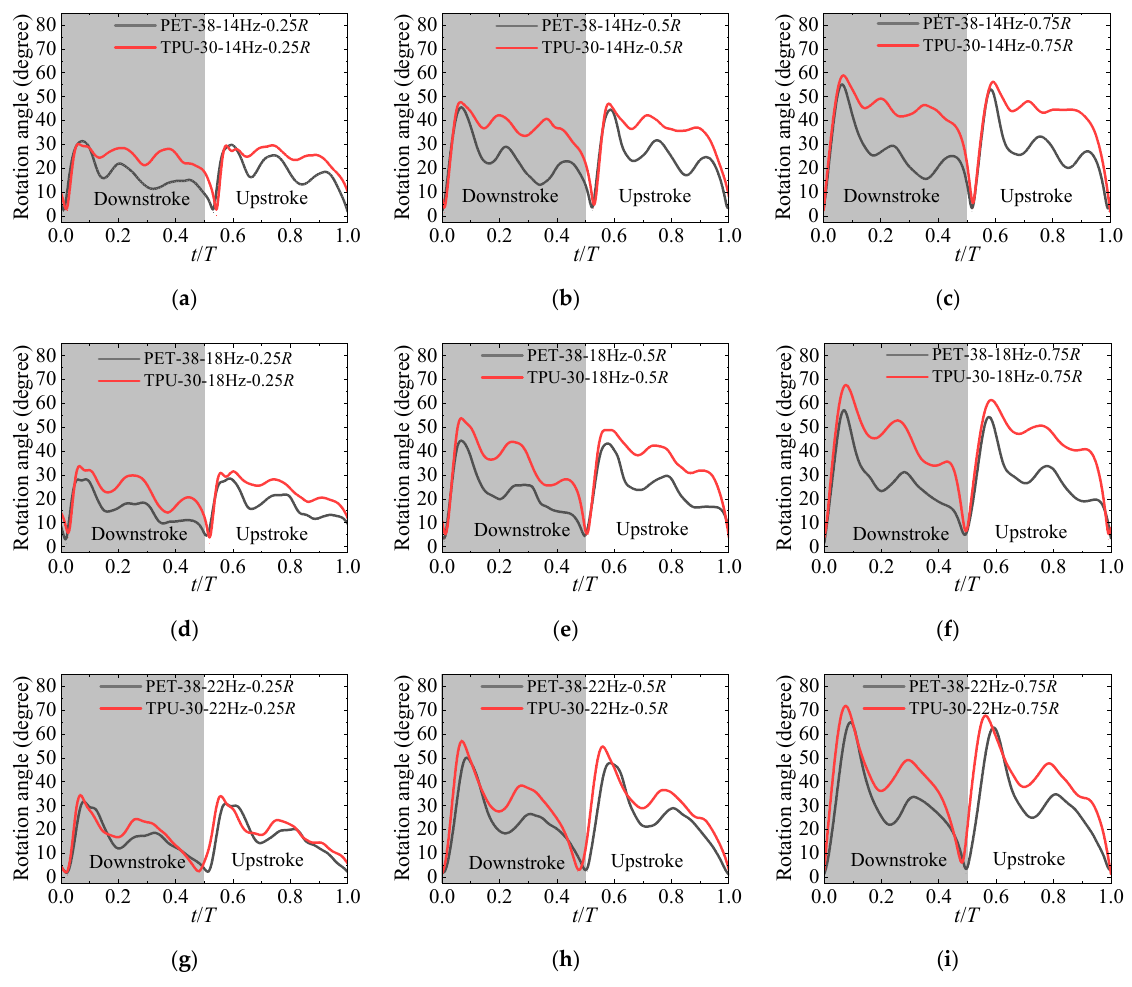
Figure 12. Deformation comparison of different wing sections at: ( a ) 0.25 R of 14 Hz; ( b ) 0.5 R of 14 Hz; ( c ) 0.75 R of 14 Hz; ( d ) 0.25 R of 18 Hz; ( e ) 0.5 R of 18 Hz; ( f ) 0.75 R of 18 Hz; ( g ) 0.25 R of 22 Hz; ( h ) 0.5 R of 22 Hz; ( i ) 0.75 R of 22 Hz.